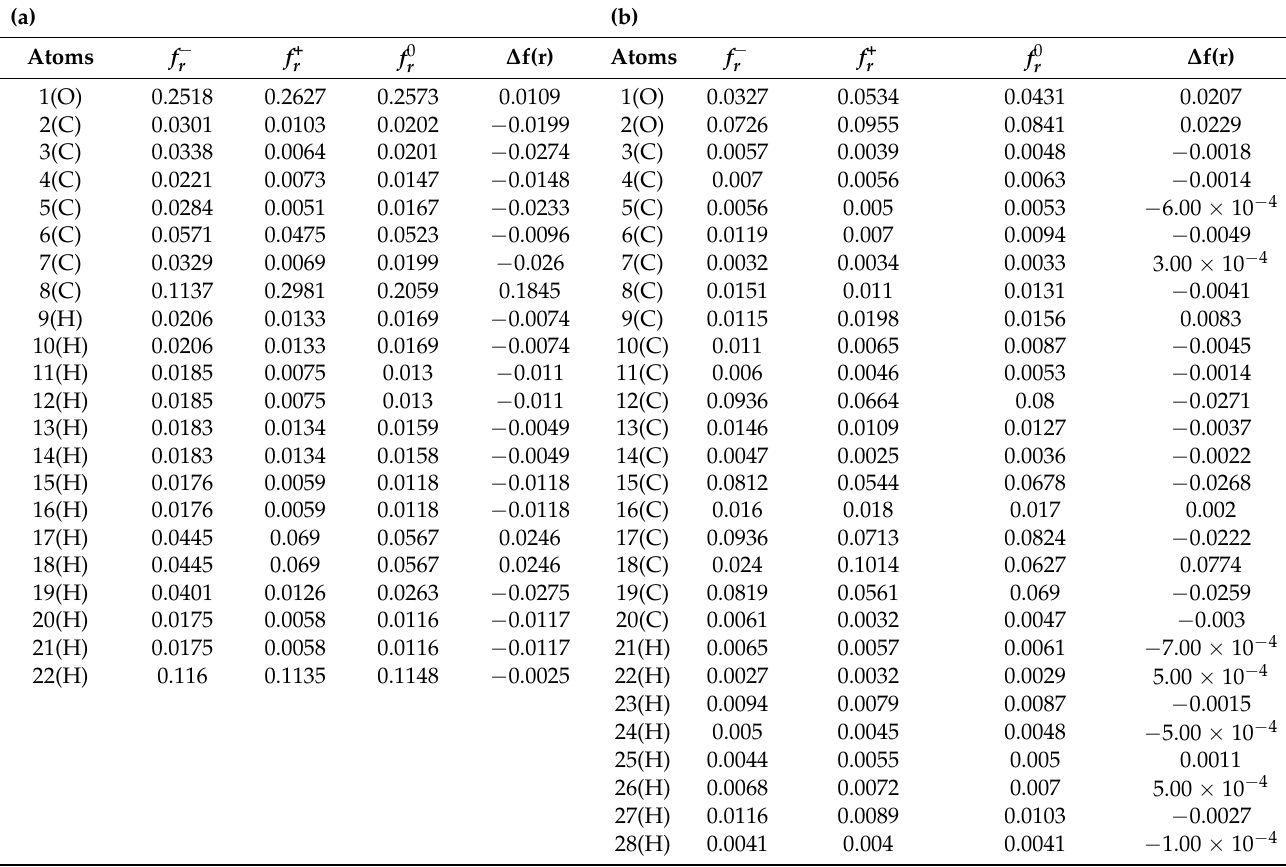
Table 4. The condensed Fukui functions for heptanal (a) and linoleic acid